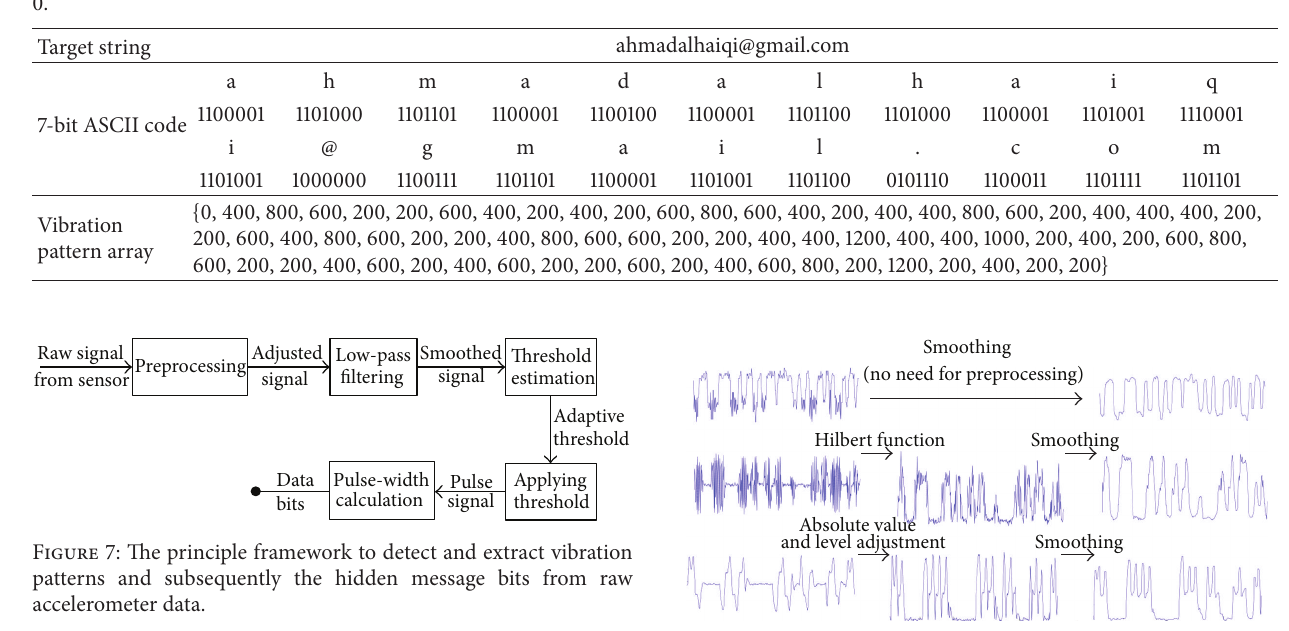
Figure 8: Different vibration patterns need different preprocessing approaches. The typical shapes we encountered during our evalu- ation of the proposed covert channel are presented below. In the first case no preprocessing is needed as the vibrations are easily distinguishable from the rest of acceleration samples at